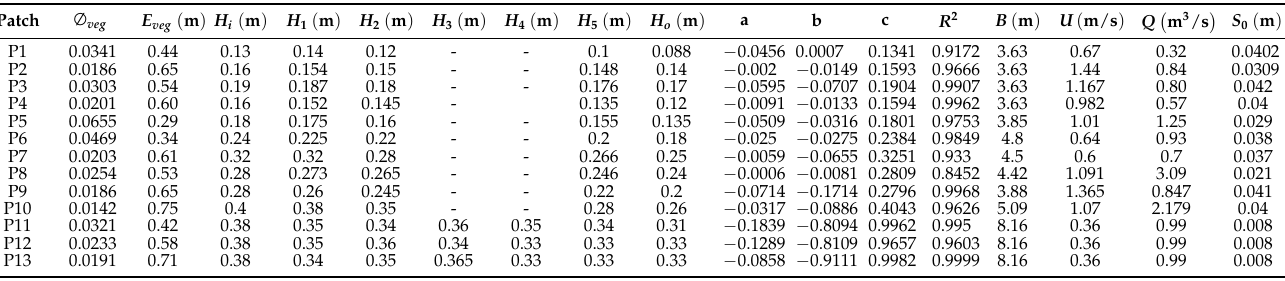
Table A1. Parameters of each vegetal